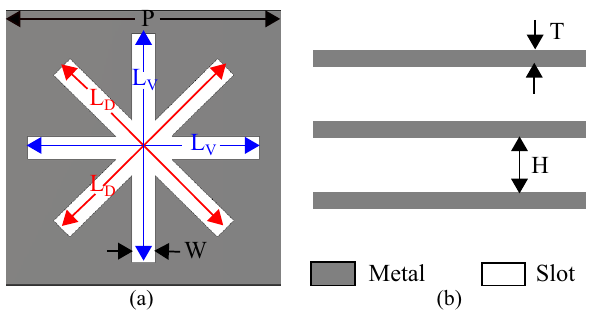
Figure 1. Configuration of the dielectric-free phase-shifting cell: ( a ) Top view; ( b ) Side view showing the three metal